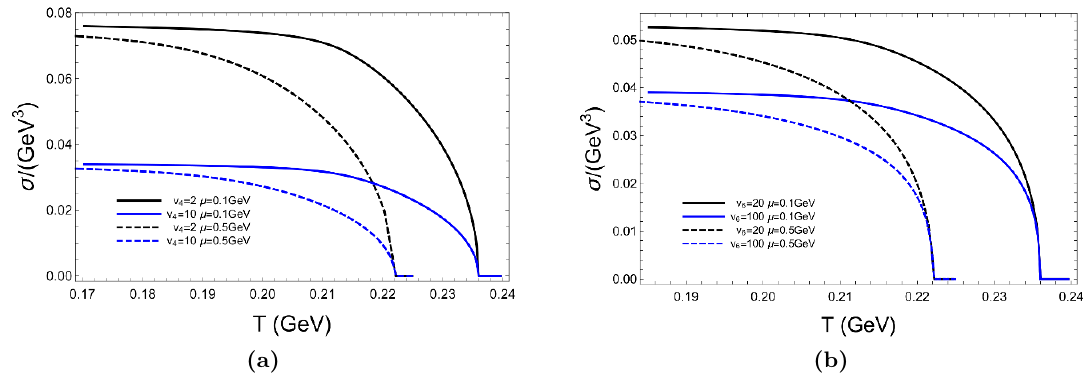
Figure 4. Chiral condensate (cid:27) in chiral limit ( m q = 0) as a function of the temperature T for di(cid:11)erent potentials V ( (cid:31); F 2 ) and chemical potentials. Panel (a) gives the results for V ( (cid:31); F 2 ) = (cid:0) 3 (cid:31) 2 + v 4 (cid:31) 4 when v 4 = 2 ; (cid:22) = 0 : 1 GeV (black solid line), v 4 = 2 ; (cid:22) = 0 : 5 GeV (black dashed line), 2 v 4 = 10 ; (cid:22) = 0 : 1 GeV (blue solid line), v 4 = 10 ; (cid:22) = 0 : 5 GeV (blue dashed line). Panel (b) gives the results for V ( (cid:31); F 2 ) = (cid:0) 3 (cid:31) 2 + v 6 (cid:31) 6 when v 6 = 20 ; (cid:22) = 0 : 1 GeV (black solid line), v 6 = 20, 2 (cid:22) = 0 : 5 GeV (black dashed line), v 6 = 100 ; (cid:22) = 0 : 1 GeV (blue solid line), v 6 = 100 ; (cid:22) = 0 : 5 GeV (blue dashed